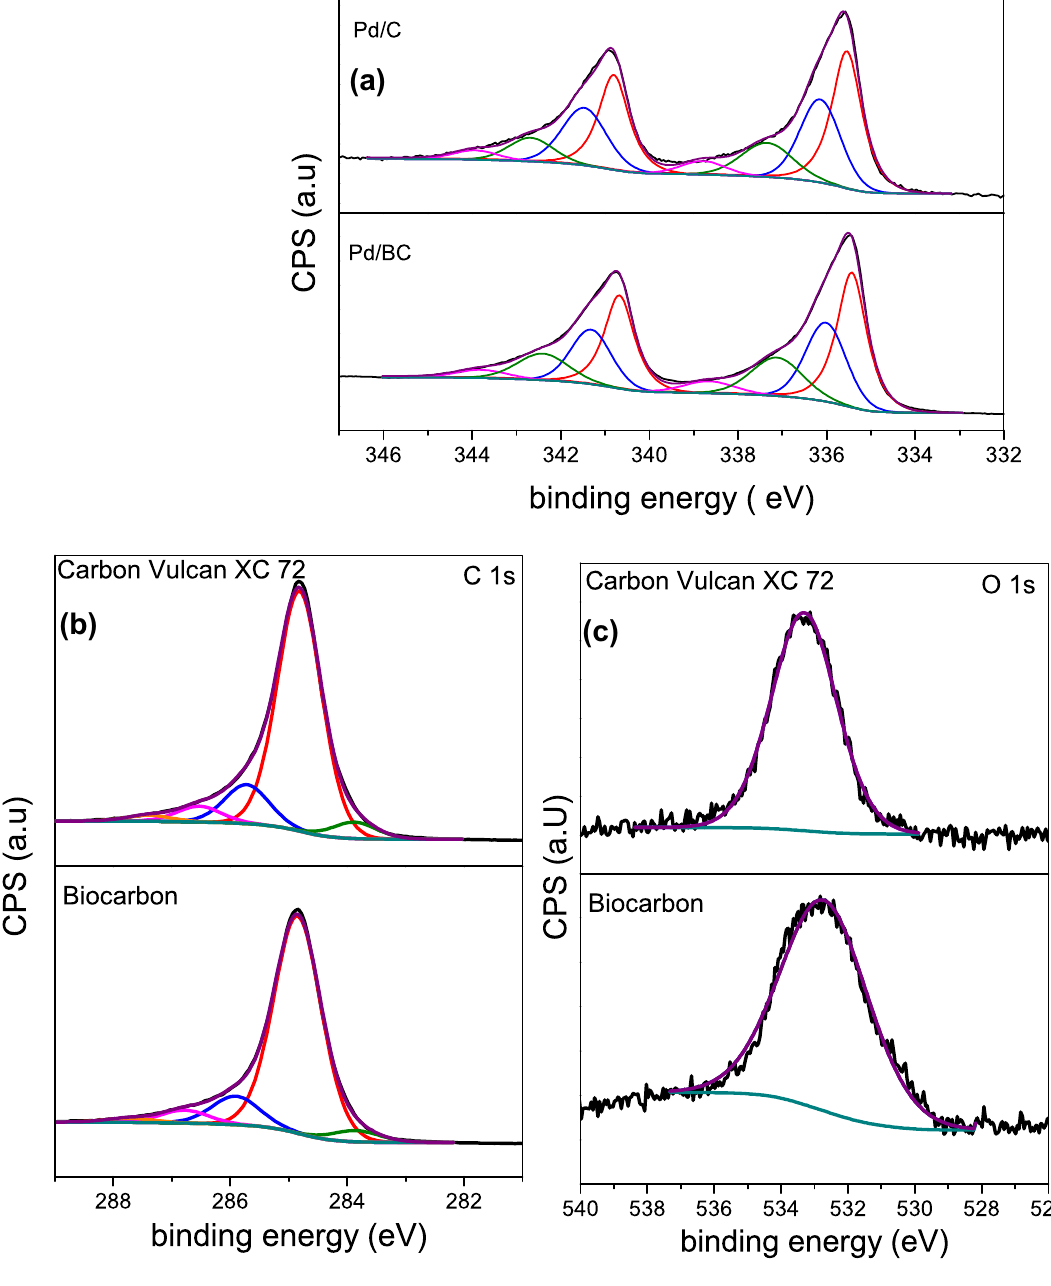
Fig. 3 XPS results of the Pd 3d region ( a ), C 1 s ( b ) and O 1 s ( c